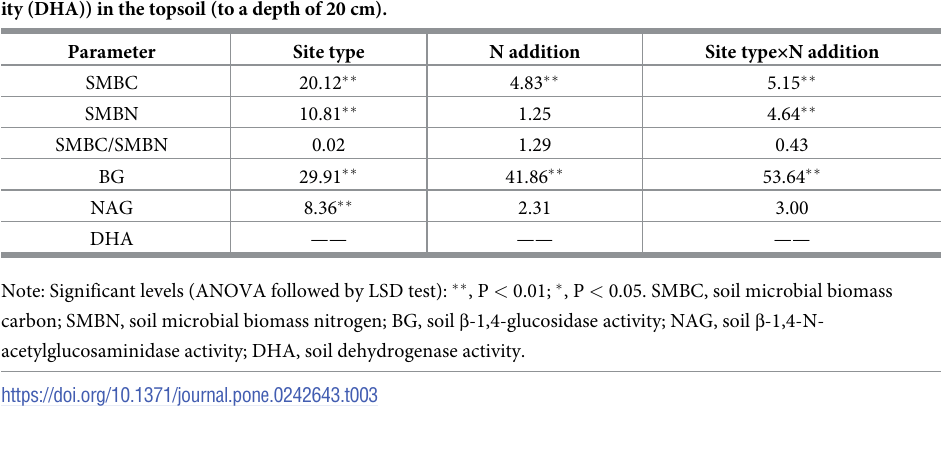
Table 3. Two-way ANOVA results of site type, N addition and their interactions on soil microbial biomass indices (soil microbial biomass carbon (SMBC), soil microbial biomass nitrogen (SMBN), and SMBC/SMBN ratio) and